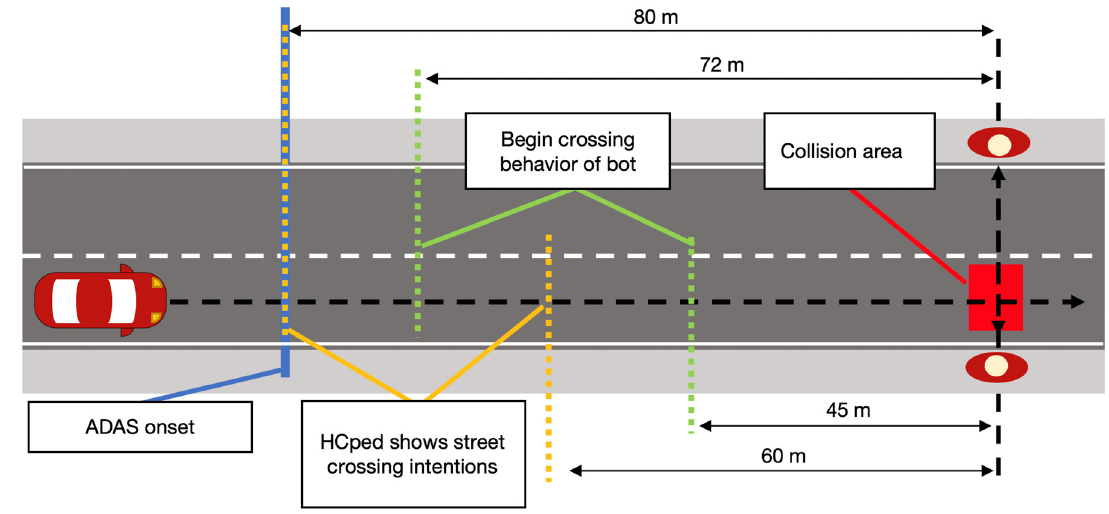
Figure 2. Schematic of street crossing situations.